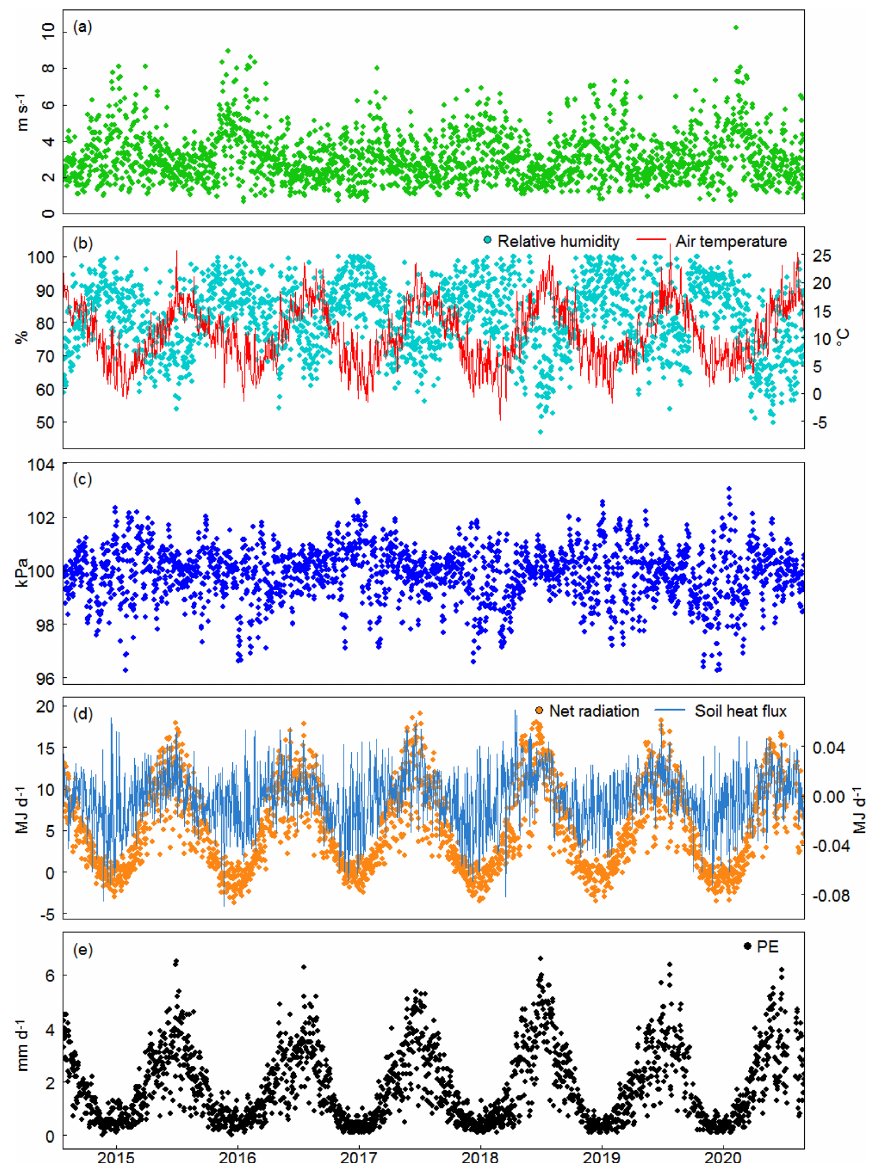
Figure 8. Daily COSMOS-UK observations required for the calculation of potential evaporation (PE) and derived PE at the Rothamsted site in East Anglia. (a) Wind speed; (b) relative humidity and air temperature; (c) barometric pressure; (d) net radiation and soil heat flux; (e) potential